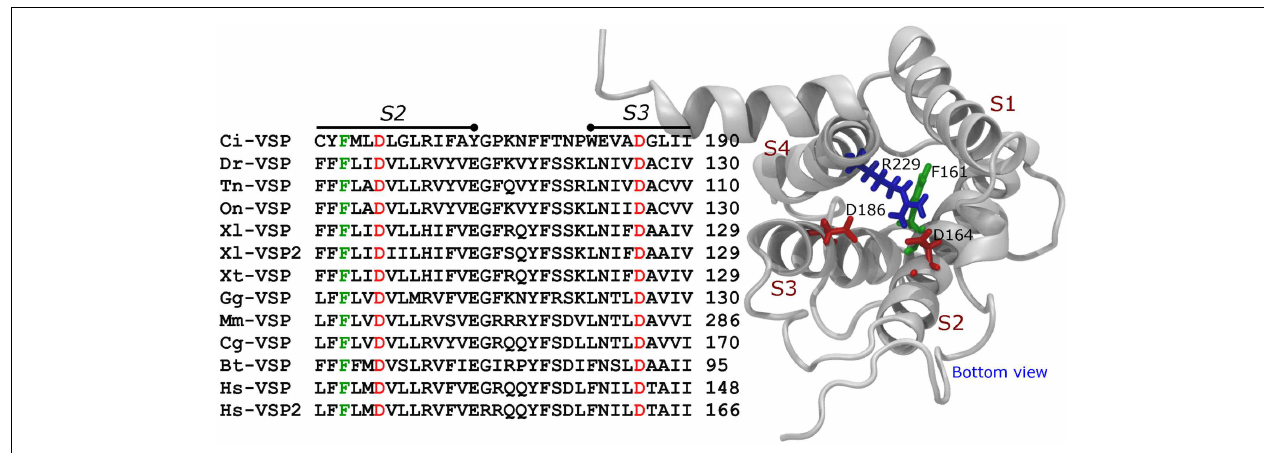
conserved residues inVSPs.These are the equivalents to F161, D164, and D186 in Ci-VSP.These residues are also found inVGC (see